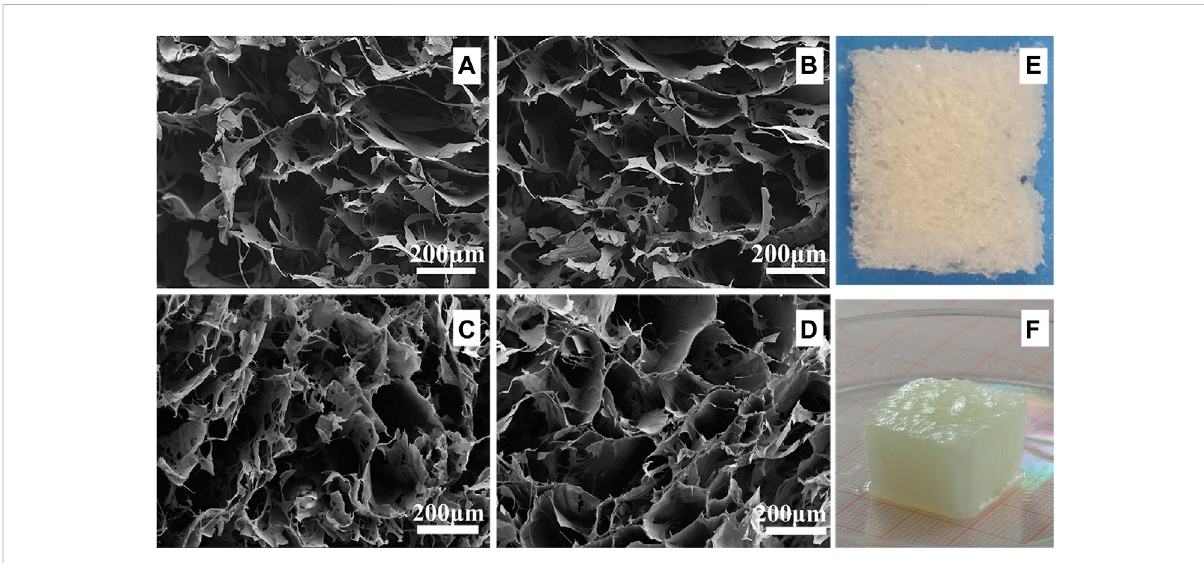
FIGURE 3 SEM images and digital photographs of CNC/COL hydrogels with different CNC concentrations. (A) 2.5 wt.% CNC, (B) 5 wt.% CNC, (C) 10 wt.% CNC, and (D) 15 wt.% CNC; (E) and (F) are the digital photographs of the cryogel and the hydrogel with 15 wt.%